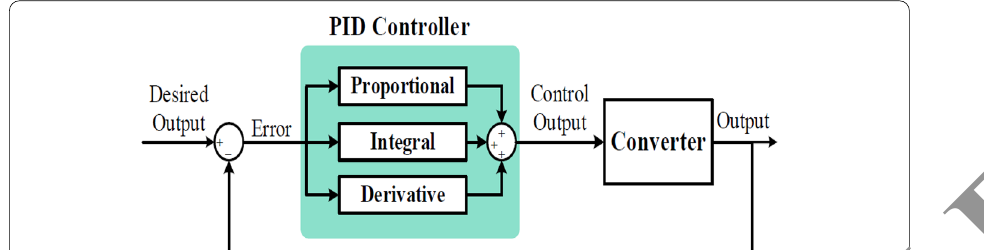
Fig. 10 The basic structure of PID controller